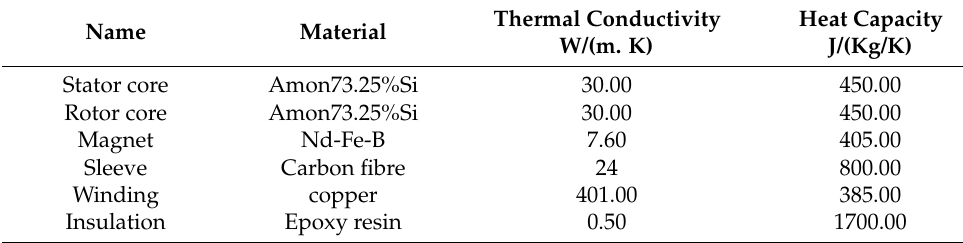
Table 3. Comparison of traditional and novel silicon steel